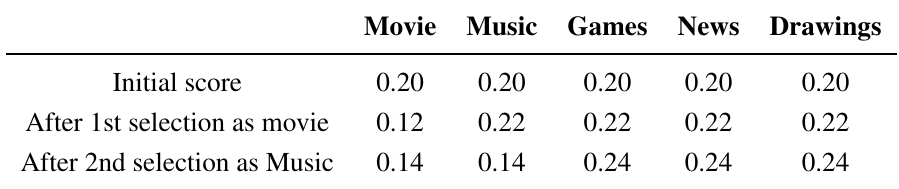
Table 4. Used score and its changes after each media